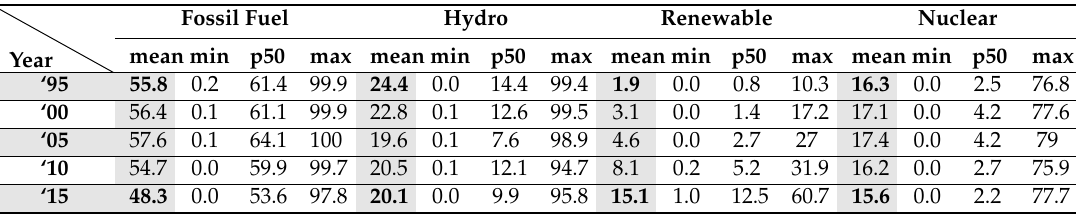
Table 3. Descriptive Statistics of the 34 Organization for Economic Cooperation and Development (OECD) Countries’ Energy